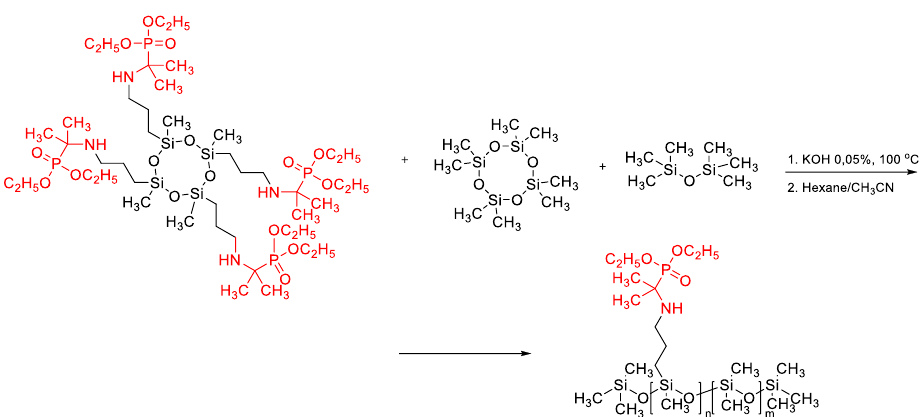
Figure 33. The copolymerization of D 4 with phosphorus-substituted cyclosiloxane. Perju E. [152] presents the synthesis of three new tetracyclosiloxane monomers modified with either nitroaniline (NA) or the Disperse Red 1 (DR1) group and their ring-opening polymerization reaction in the presence of tetramethylammonium hydroxide (Figure 34). Because of their high dielectric constant of 17.3 at RT. and rather low Tg, NA-modified polymers are attractive as active dielectric materials in actuating elements, capacitors, and flexible electronics [153].